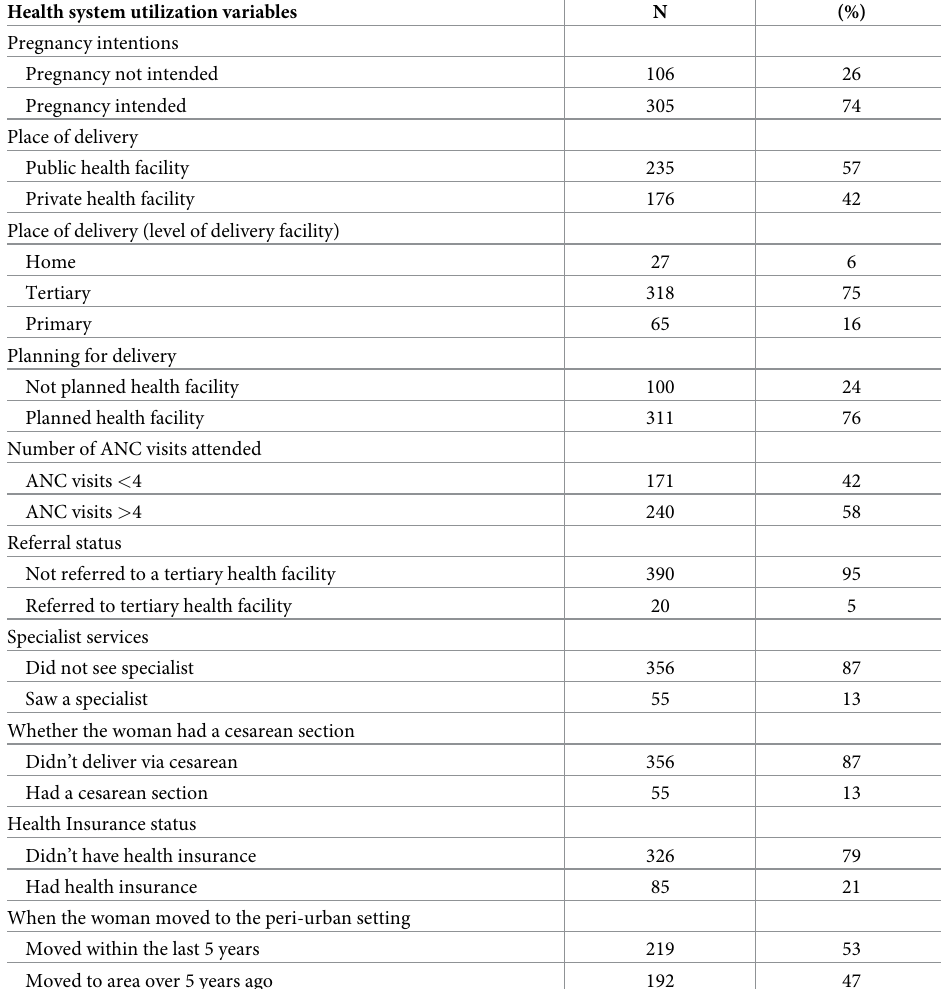
Table 3. Health system utilization variables for women in peri-urban setting women (N = 411). Health system utilization